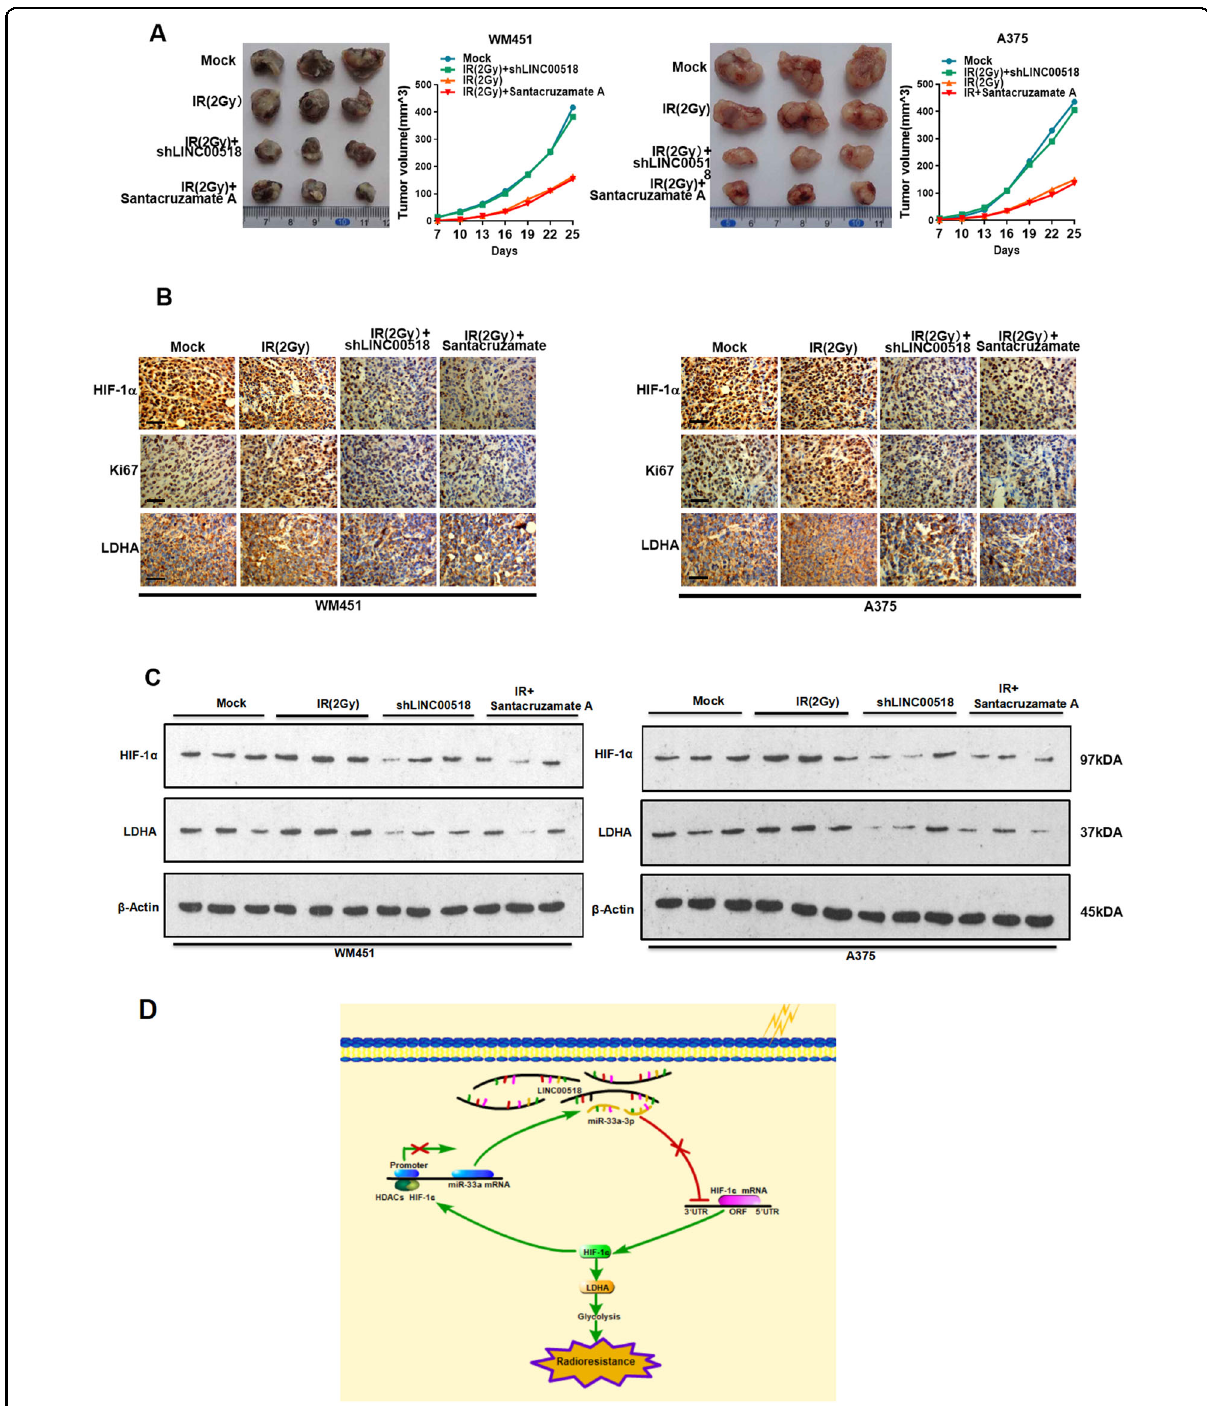
Fig. 8 Effect of the LINC00518 /miR-33a-3p/HIF-1 α negative feedback loop on radiosensitivity in CMM cells in vivo. A Transplantation tumor experiments showing that repression of LINC00518 expression using the shLINC00518 plasmid or treating the cells with Santacruzamate A reduced the tumorigenic ability and tumor volume of WM451 and A375 cells, thereby increasing their radiosensitivity as observed by reduced colony formation in the subcutaneous sarcoma model. B Immunohistochemical assays showing that knockdown of LINC00518 expression or treating the cells with Santacruzamate A decreased HIF-1 α , Ki67, and LDHA protein levels in tumor tissues of mice. C Western blotting showing that LINC00518 expression or treatment of the cells with Santacruzamate A decreased HIF-1 α and LDHA protein expression in tumor tissues of mice. D Schematic of this search. The histogram data for each group are an average of three independent replicates; bars indicate SD; * P < 0.05, ** P < 0.01, *** P <